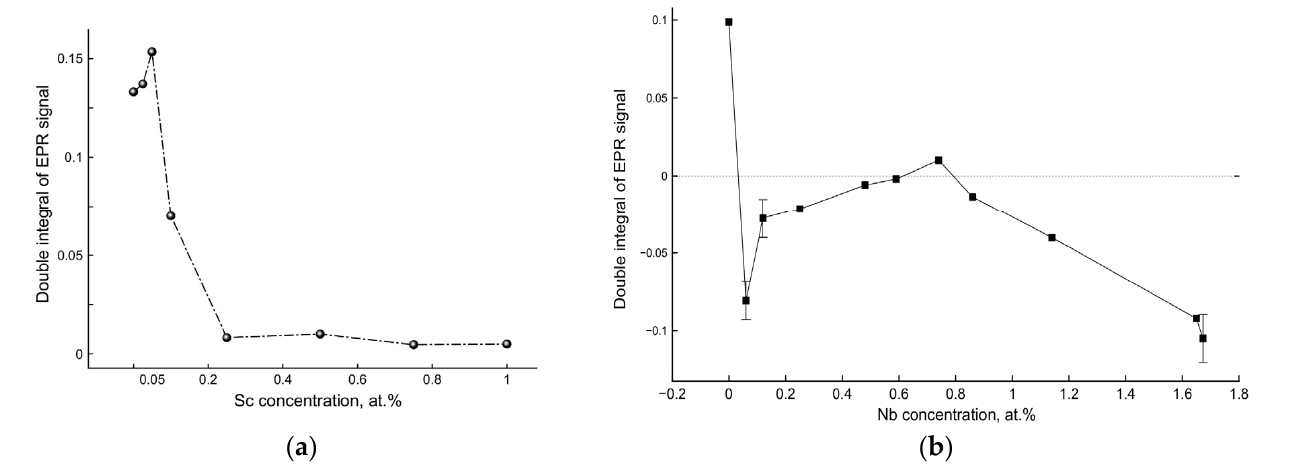
Figure 6. Dependences of the double-integrated EPR signal corresponding to the number of photoinduced paramagnetic Ti 3+ states on the dopant concentrations in: ( a ) Sc-doped TiO 2 and ( b ) Nb-doped TiO 2 .